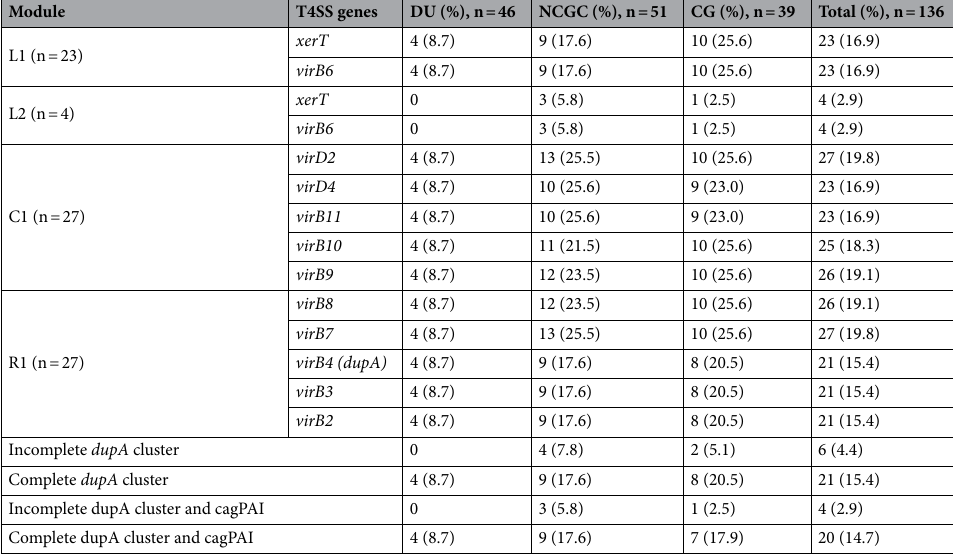
Table 3. Prevalence of dupA cluster in DU, NCGC, and CG.